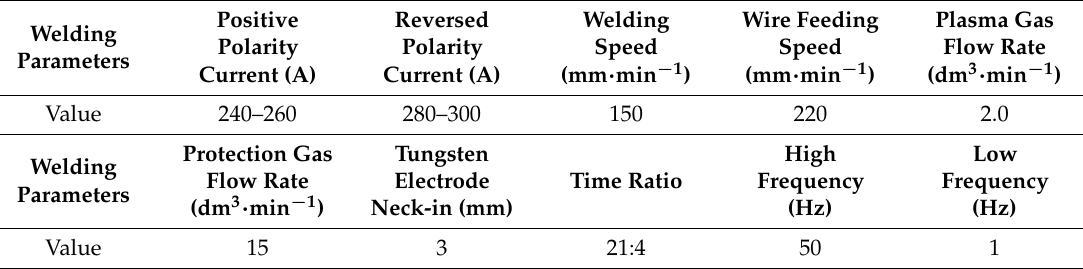
Figure 1. Welding equipment. Table 2. Welding parameters of PVPPA.